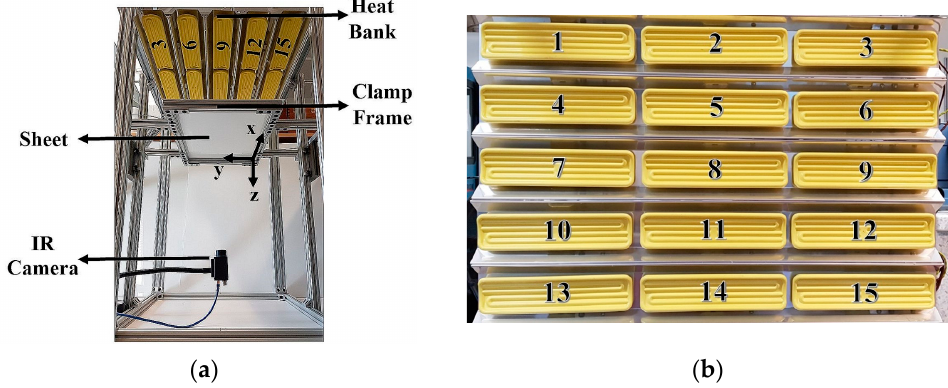
Figure 6. ( a ) Laboratory-scale heating system setup; ( b ) number of heating elements.